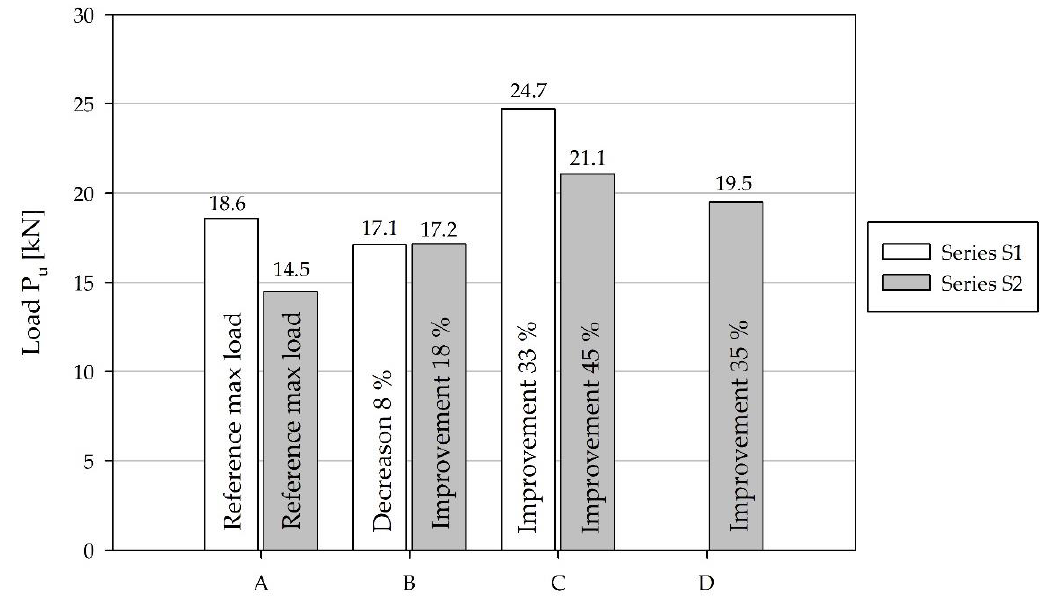
Figure 9. Average load-bearing capacity (P u ) of the beams of type A, B, C, and D, and the improvement in this capacity of the beams of types B, C, and D compared to the type A beams.